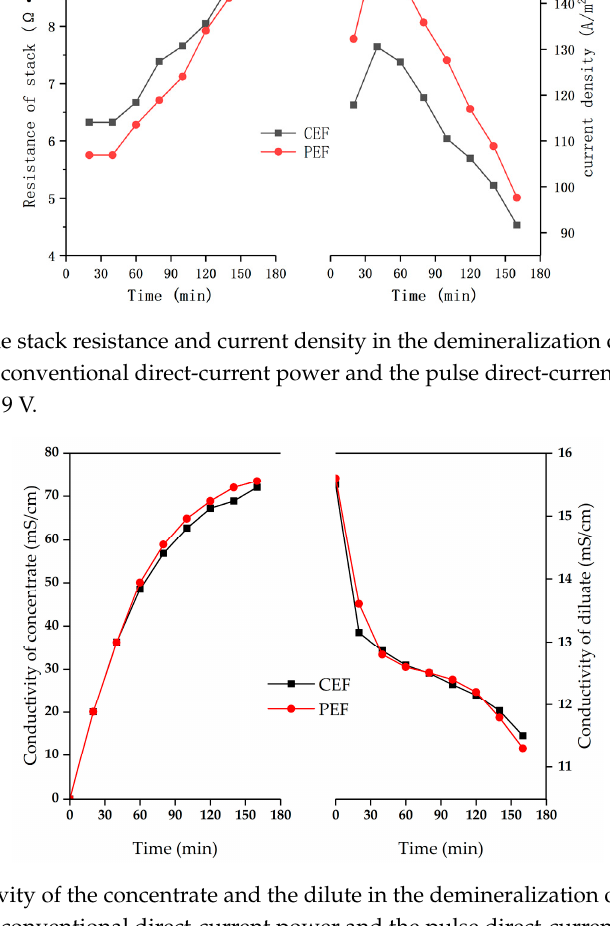
Figure 5. Conductivity of the concentrate and the dilute in the demineralization of sodium gluconate mother liquor. The conventional direct-current power and the pulse direct-current power operated at constant voltage of 9 V.